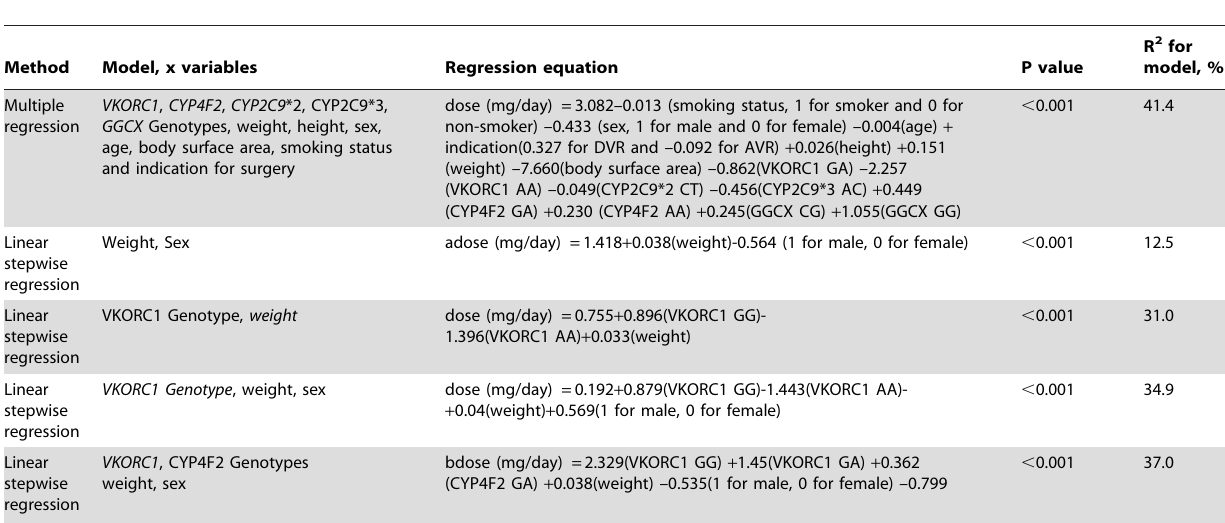
a Algorithm based only on clinical variables. b Algorithm for best fit model generated by linear stepwise regression using both clinical and genetic variables. doi:10.1371/journal.pone.0037844.t002 PLoS ONE |